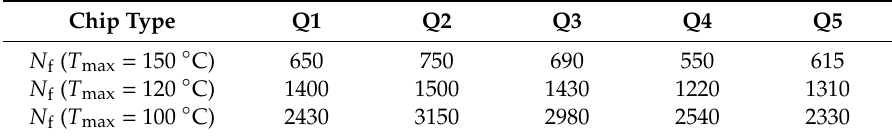
Figure 5. SEM observation of crack nucleation of chip Q2 at S12 and S45. Table 1. Thermal cyclic fatigue test results.